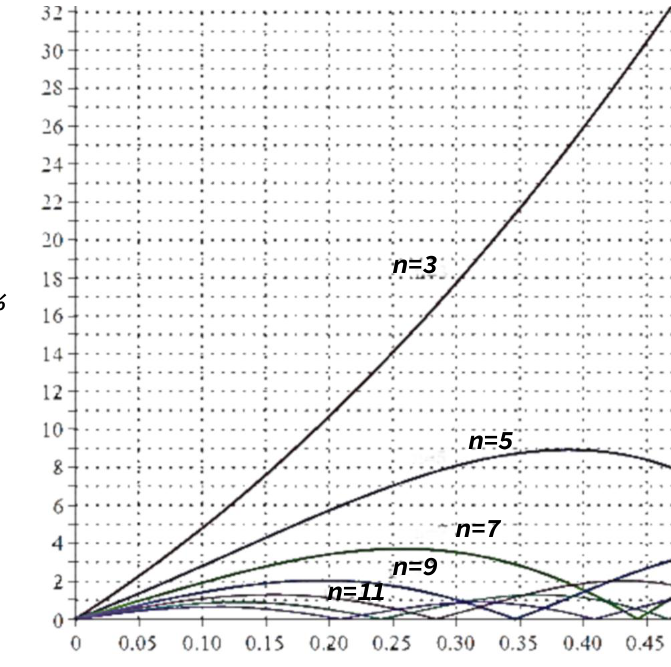
Figure 6. THDi of topology vs gain ( m ).